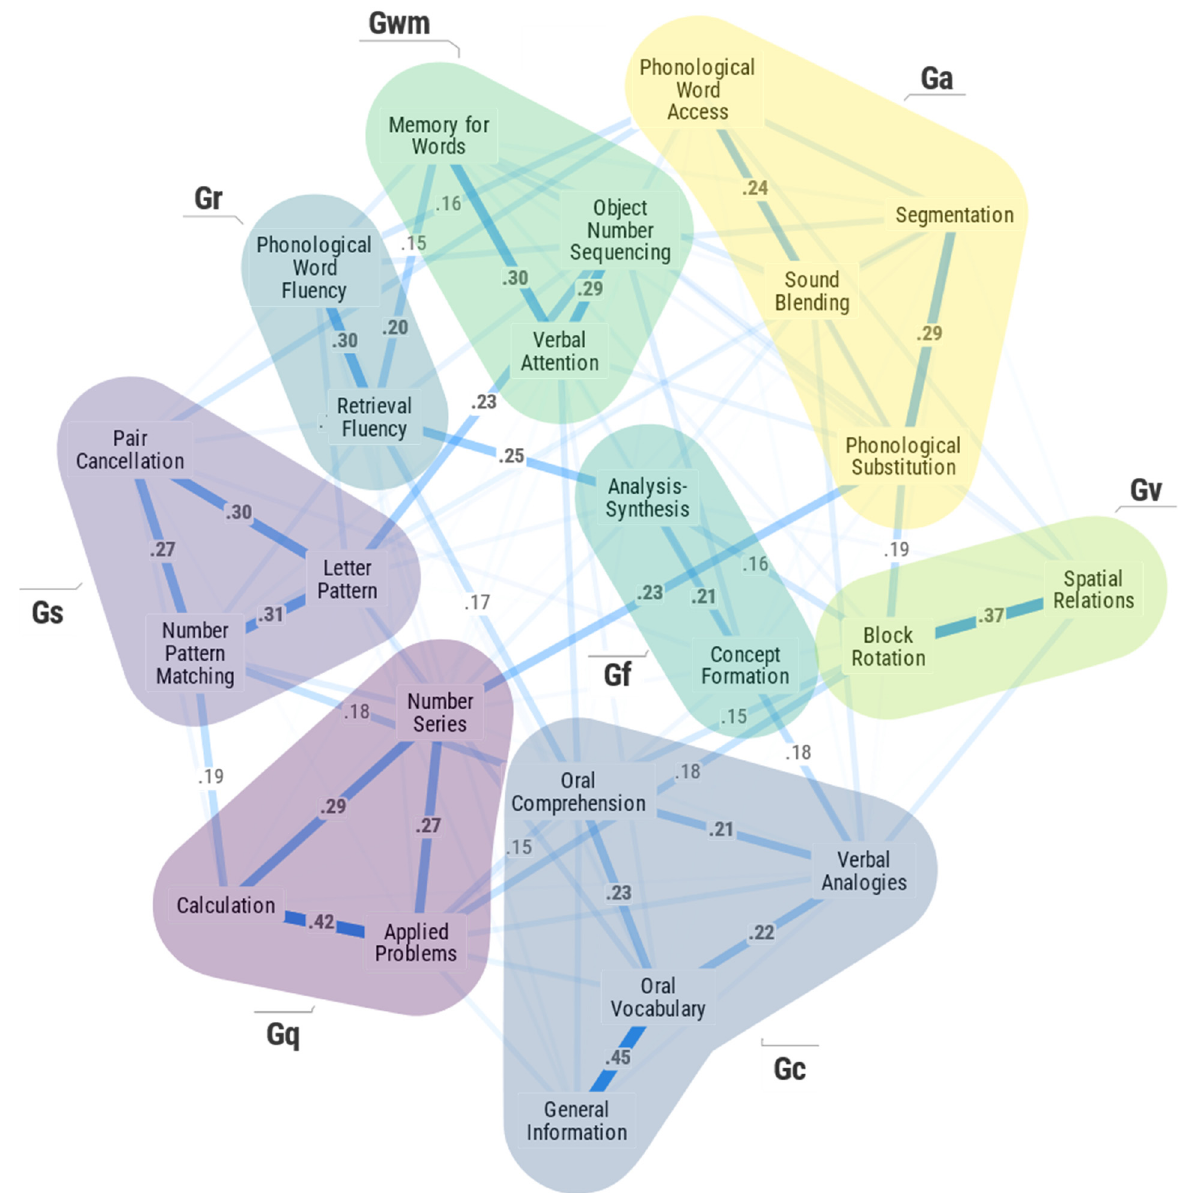
Figure 2. Weighted undirected network structure of 23 select WJ IV measures of eight broad CHC abilities in the secondary sensitivity network model.